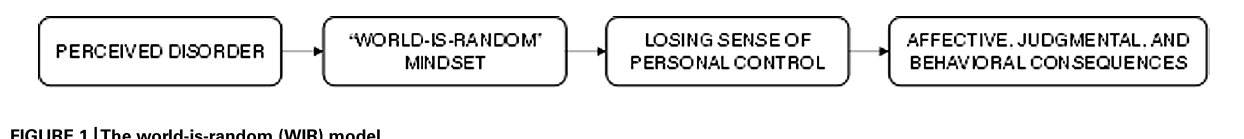
FIGURE 1 |The world-is-random (WIR)